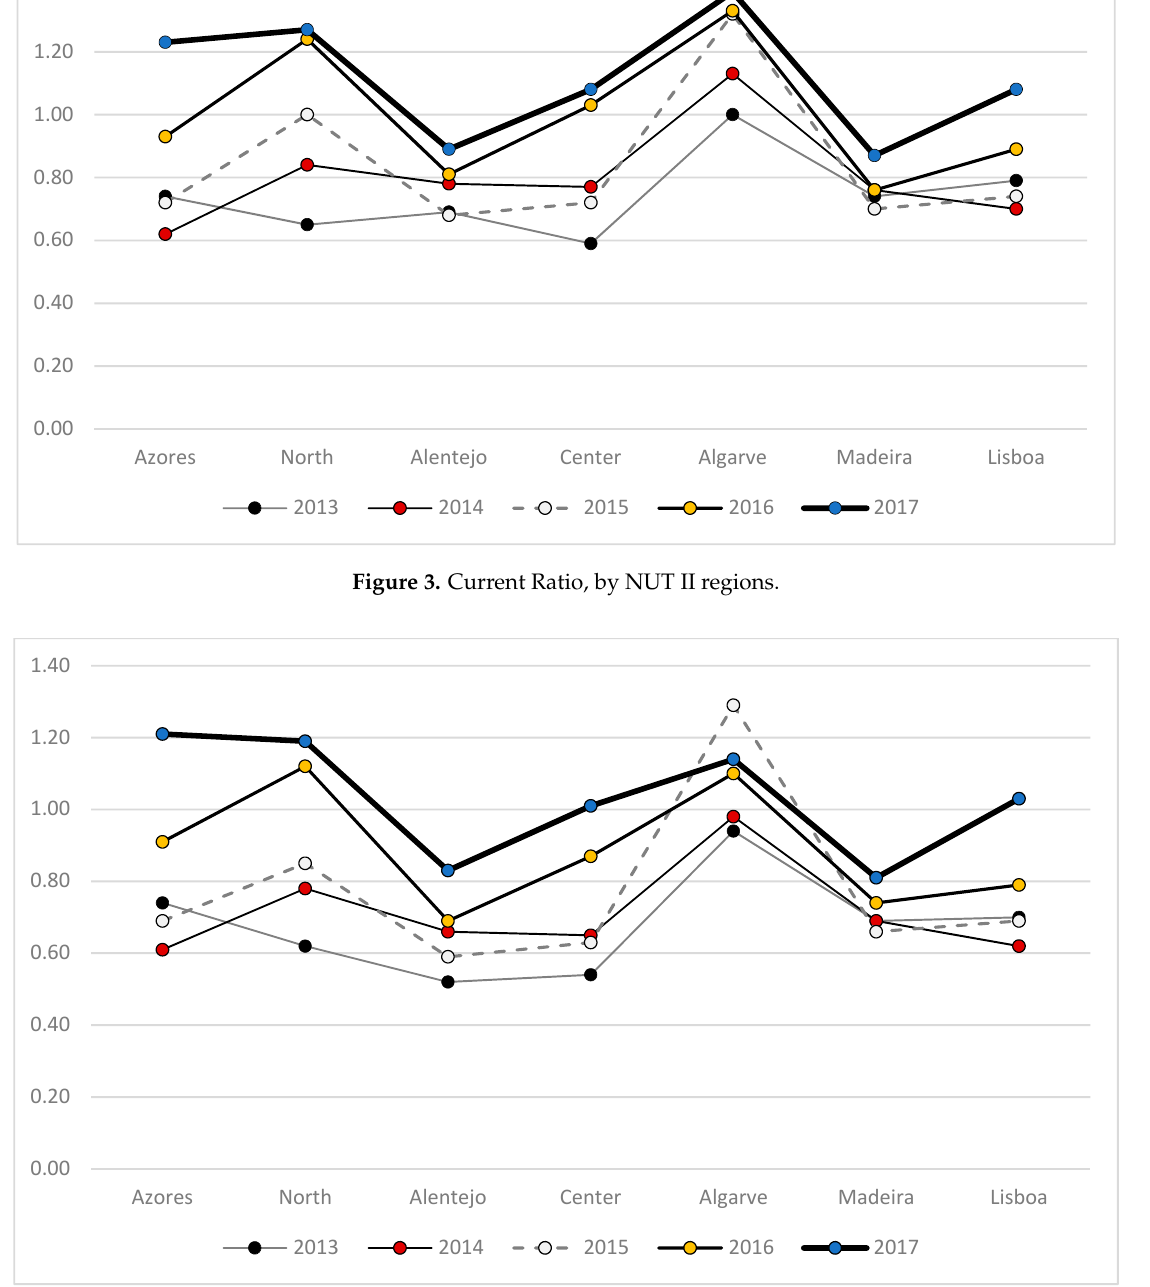
Table 10. Results of non-parametric Mann–Whitney U test. Null Hypothesis Sig.